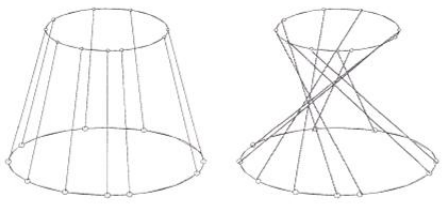
Figure 12. Correct and incorrect matching